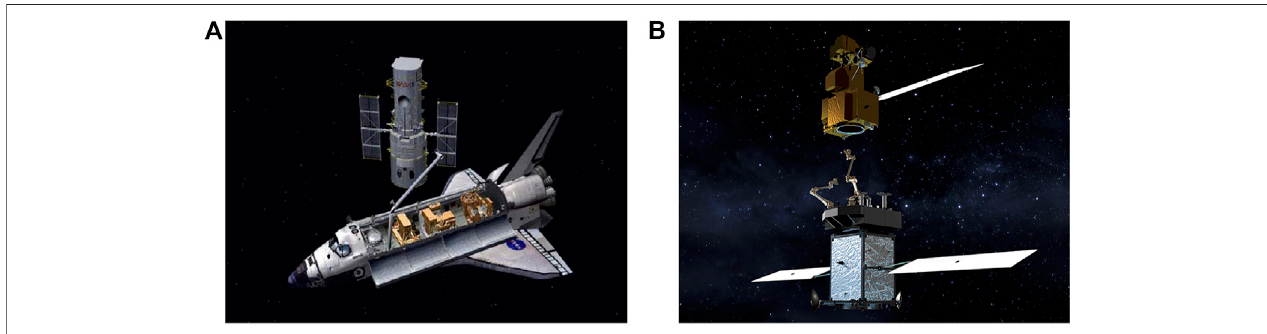
FIGURE 1 | Examples of lightweight articulated manipulators for massive object capture and transport: (A) the Hubble telescope during a repair mission, (B) satellite servicer capturing a satellite. Photo credit: NASA.